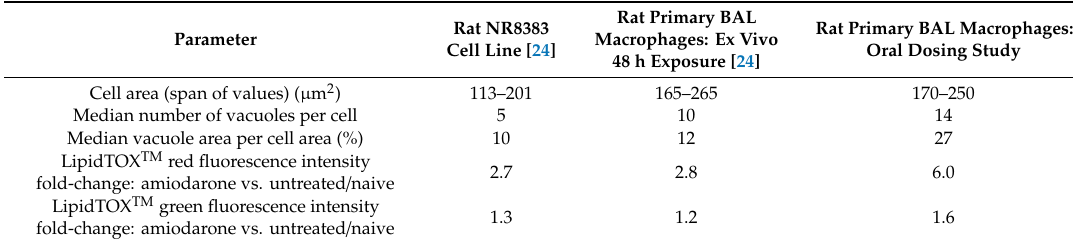
Table 3. Comparison of morphometric parameters and neutral lipid / phospholipid content between the rat cell line, NR8383, primary rat BAL macrophages from naïve rats exposed ex vivo to 10 µ M amiodarone [24] and primary rat BAL macrophages harvested from Han Wistar rats treated orally with amiodarone (Figure 3). Rat Primary BAL Rat NR8383 Rat Primary BAL Macrophages: Parameter Macrophages: Ex Vivo Cell Line [24] Oral Dosing Study 48 h Exposure [24] Cell area (span of values) ( µ m 2 ) 113–201 165–265 170–250 Median number of vacuoles per cell 5 10 14 Median vacuole area per cell area (%) 10 12 27 LipidTOX TM red fluorescence intensity 2.7 2.8 6.0 fold-change: amiodarone vs. untreated / naive